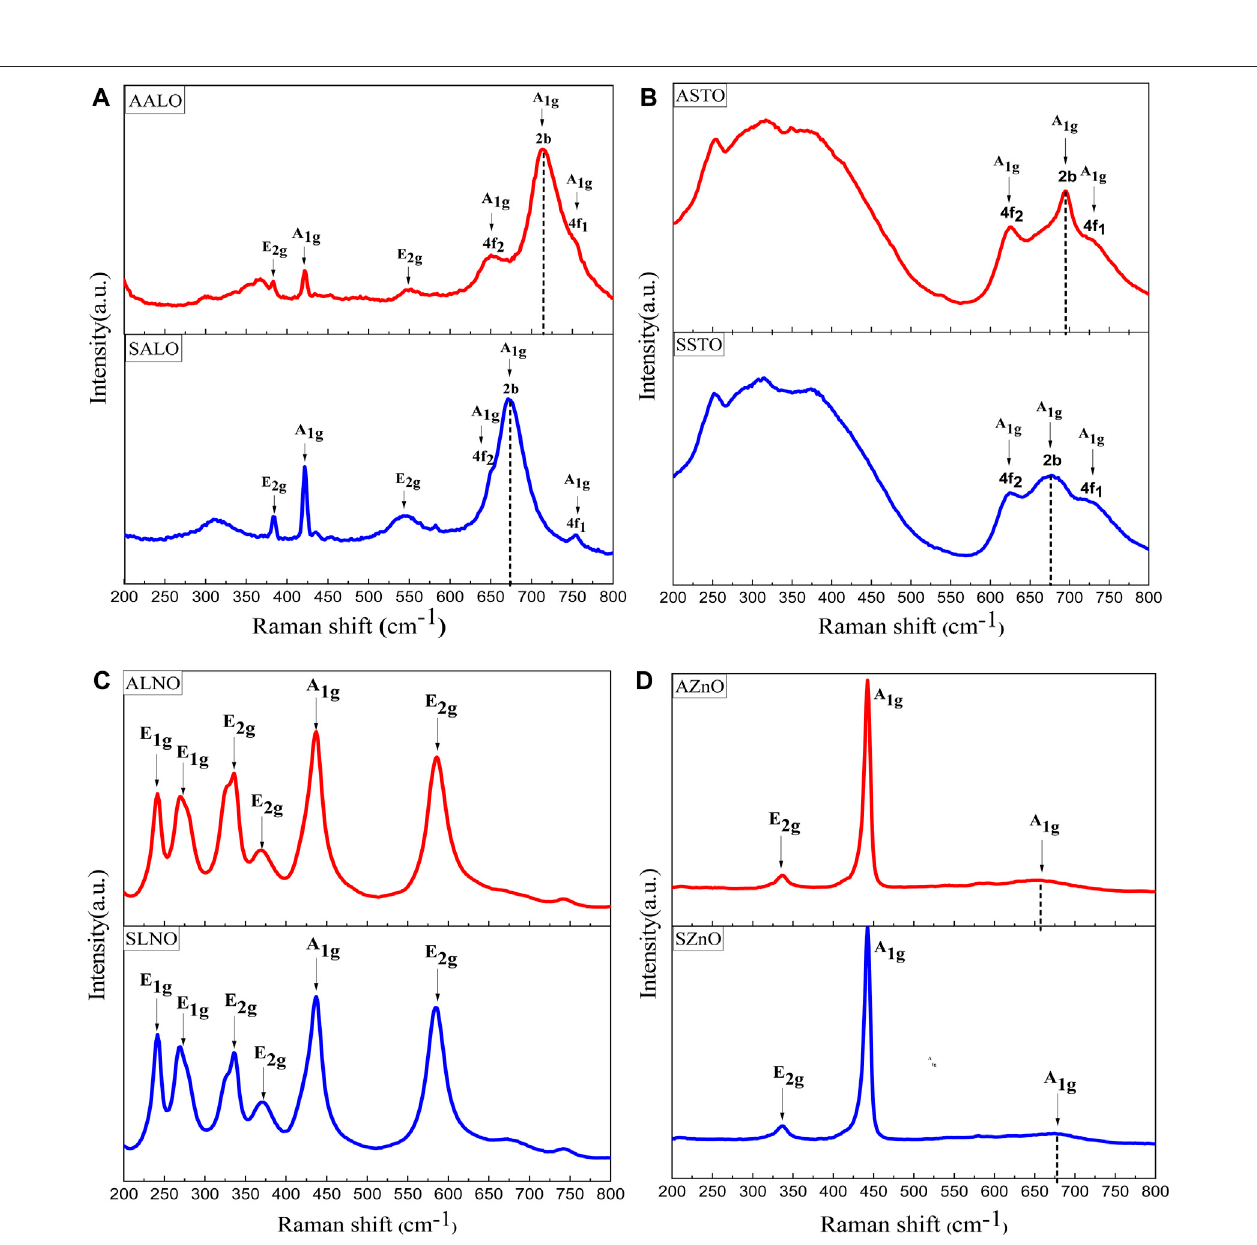
FIGURE3| RamanspectraofSrFe 12 O 19 thin fi lmsbefore(blueline)andafter(redline)annealingondifferentsubstratesshow (A) Al 2 O 3 (1102), (B) SrTiO 3 (100), (C) LiNbO 3 (0001), and (D) ZnO